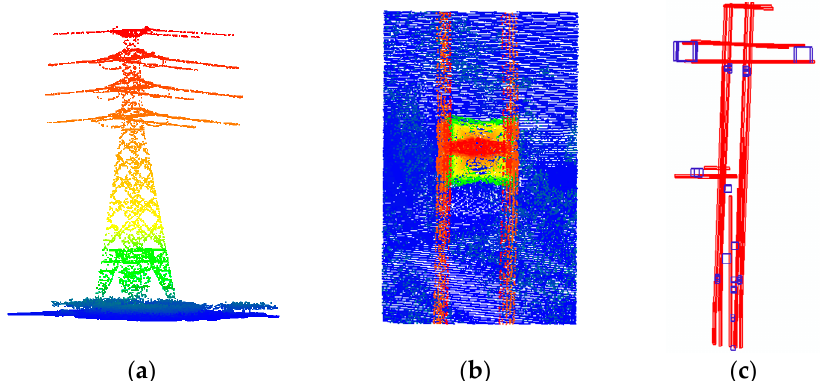
Figure 5. Potential power tower areas detection: ( a ) front view of a typical power tower; ( b ) top view of a typical power tower; ( c ) detected potential power tower areas, where the power lines are marked red, and the potential power tower areas are marked blue.